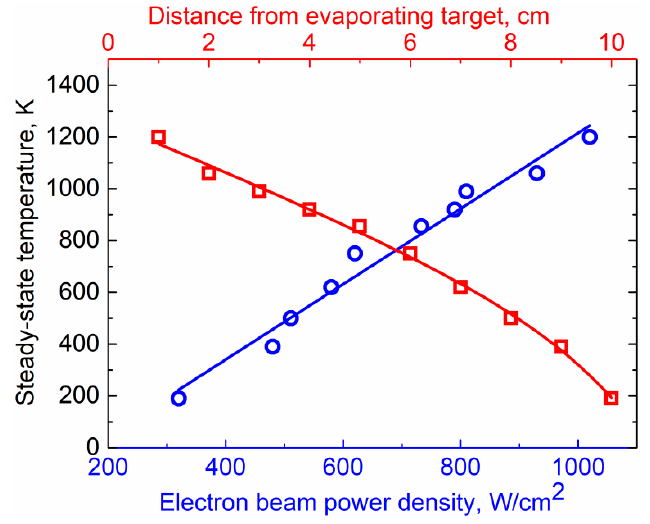
Figure 3. Steady-state temperature of the chip at a fixed distance of 2 cm from the target vs. elec- tron beam density, and steady-state temperature of the chip vs. the distance from the target at electron beam power density of 970 W/cm 2 .